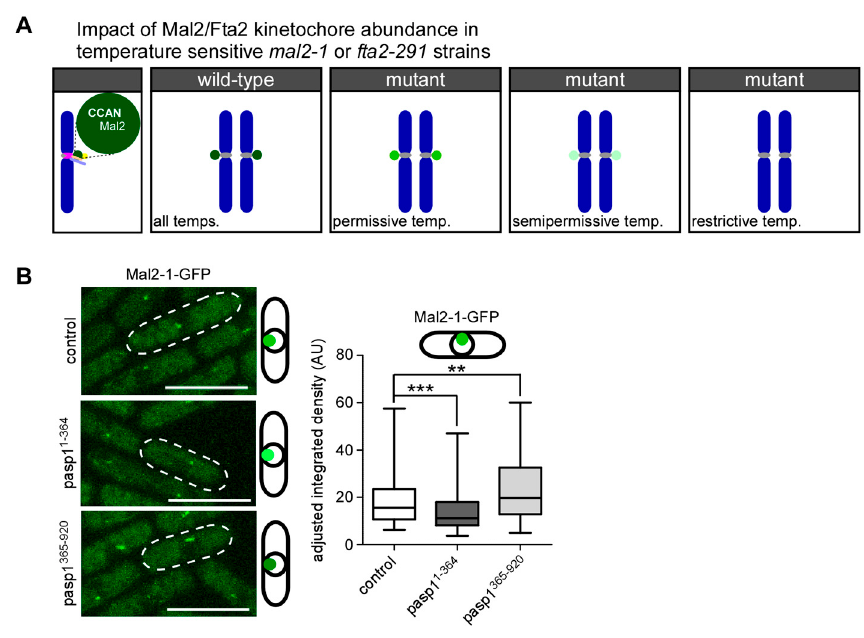
Figure 4. Negative correlation between IP 8 levels and Mal2-1-GFP kinetochore fluorescence . ( A ) Diagrammatic representation to show that Mal2-1-GFP kinetochore targeting is temperature-dependent [91]. The lighter the shade of green, the less Mal2-1-GFP is at the kinetochore. ( B ) Left: Live cell images of the indicated mal2-1-gfp transformants grown at 25 °C. Scale bar, 10 µm. Right: Quantification of Mal2-1-GFP fluorescence signals: Mean and SD: vector = 18.42 AU ± 9.7; asp1 1 − 364 = 14.53 AU ± 6.39; asp1 365 − 920 = 22.77 AU ± 12.17. Number of kinetochore signals that were counted: control: = 162; asp1 1 − 364 = 160; asp1 365 − 920 = 140; ***, p < 0.0001; **, p = 0.0019; Mann–Whitney U-Test. One of n = 2 sets shown.